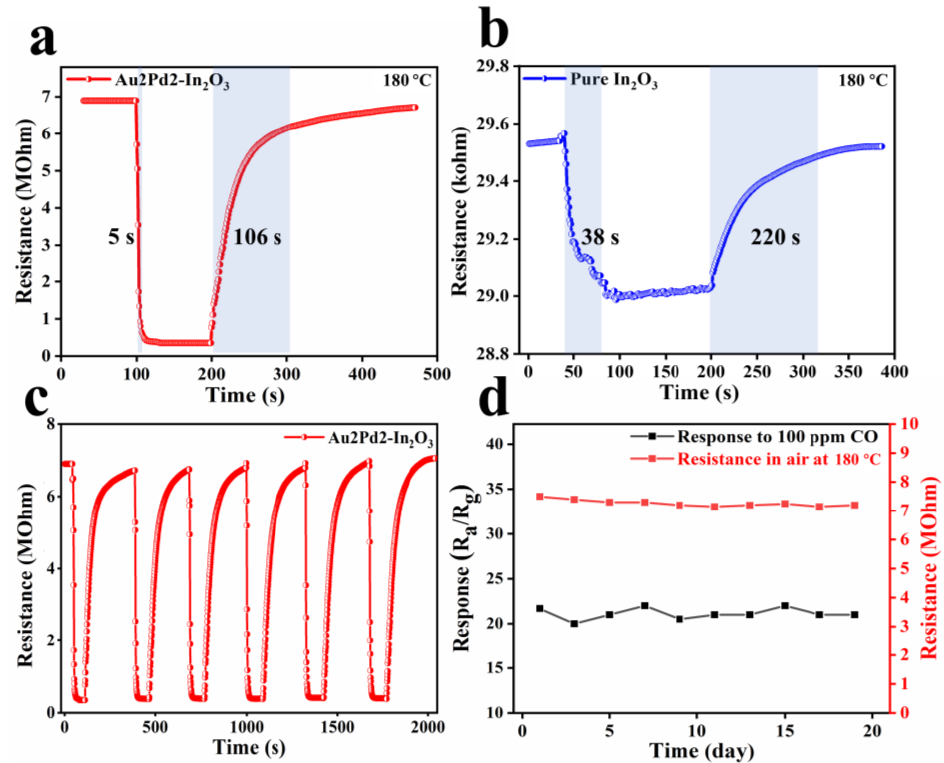
Figure 9. Dynamic response transients of sensors based on ( a ) Au2Pd2-In 2 O 3 nanofibers and ( b ) pure In 2 O 3 nanofibers to 100 ppm CO at 180 ◦ C; ( c ) six dynamic cycling response curves and ( d ) one-week